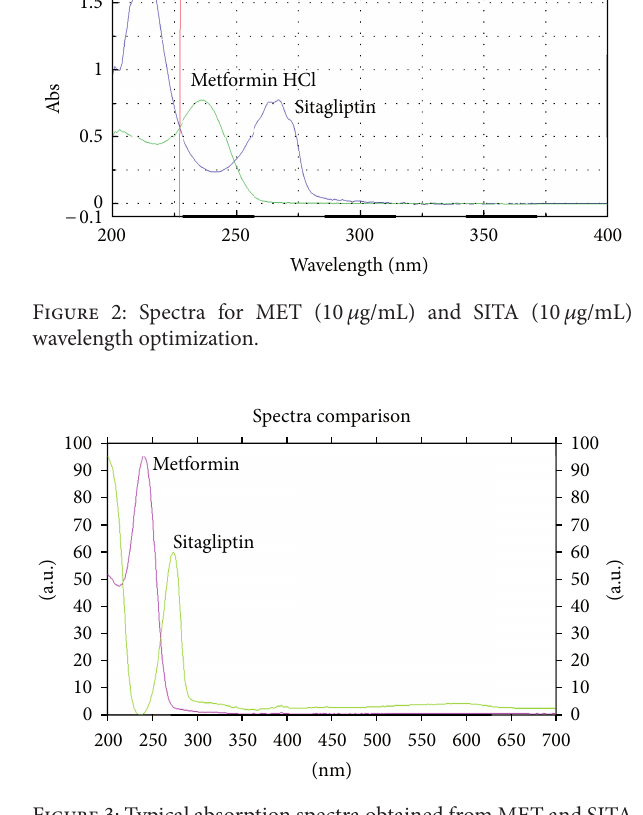
F 3: Typical absorption spectra obtained from MET and SITA drug